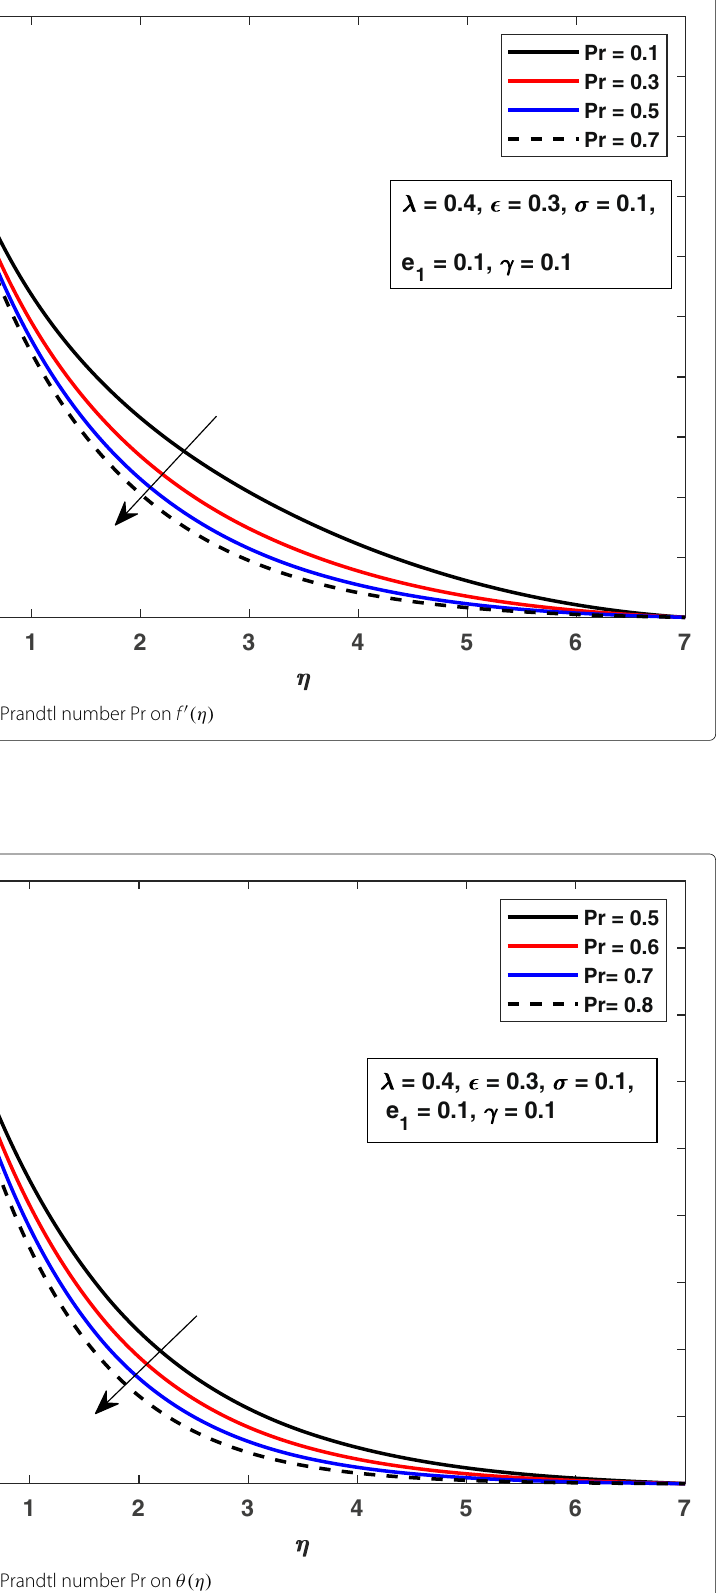
Fig. 9 Impact of the Prandtl number Pr on